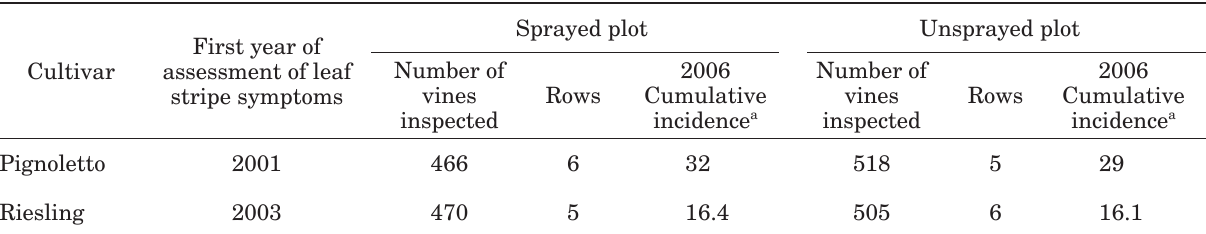
Table 2. Details of vineyards in which field trials were carried out: fields were first sprayed with CF after harvest in